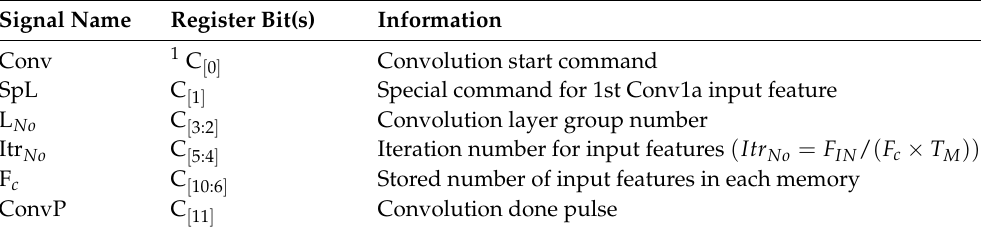
Table 1. Configuration word